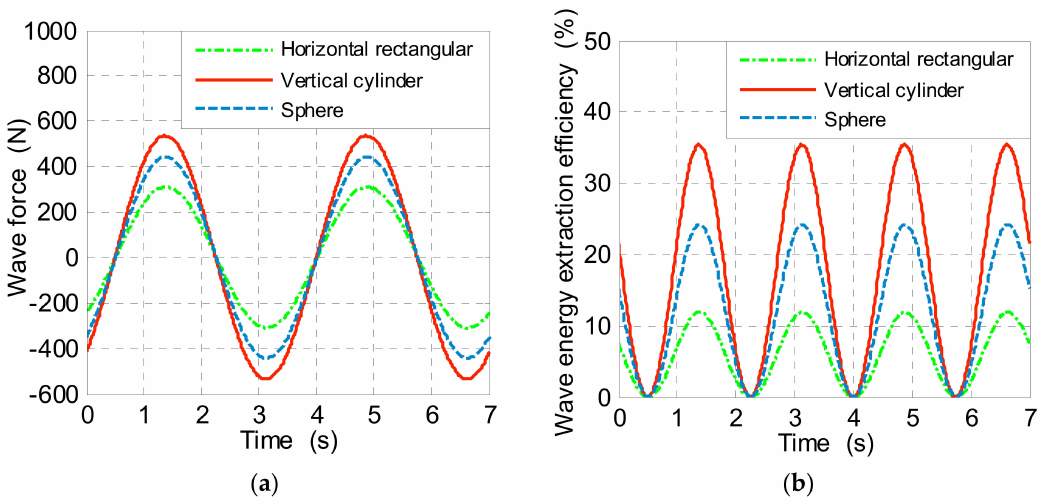
Figure 10. Interaction between multi-type surface buoys and wave motions: ( a ) wave force; ( b ) wave energy extraction e ffi ciency.